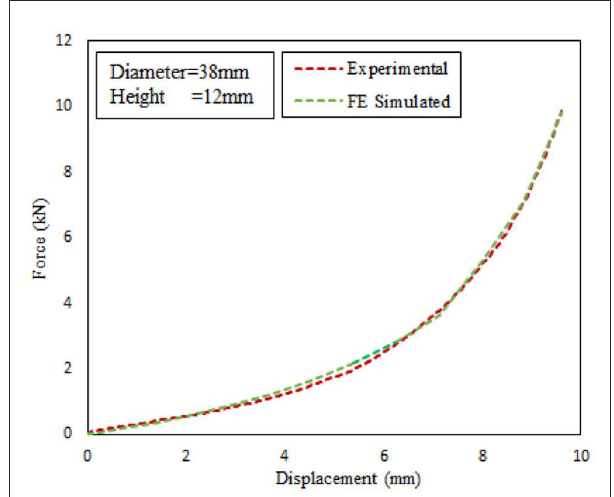
TABLE 1 FE generated variable for cylindrical indentation.